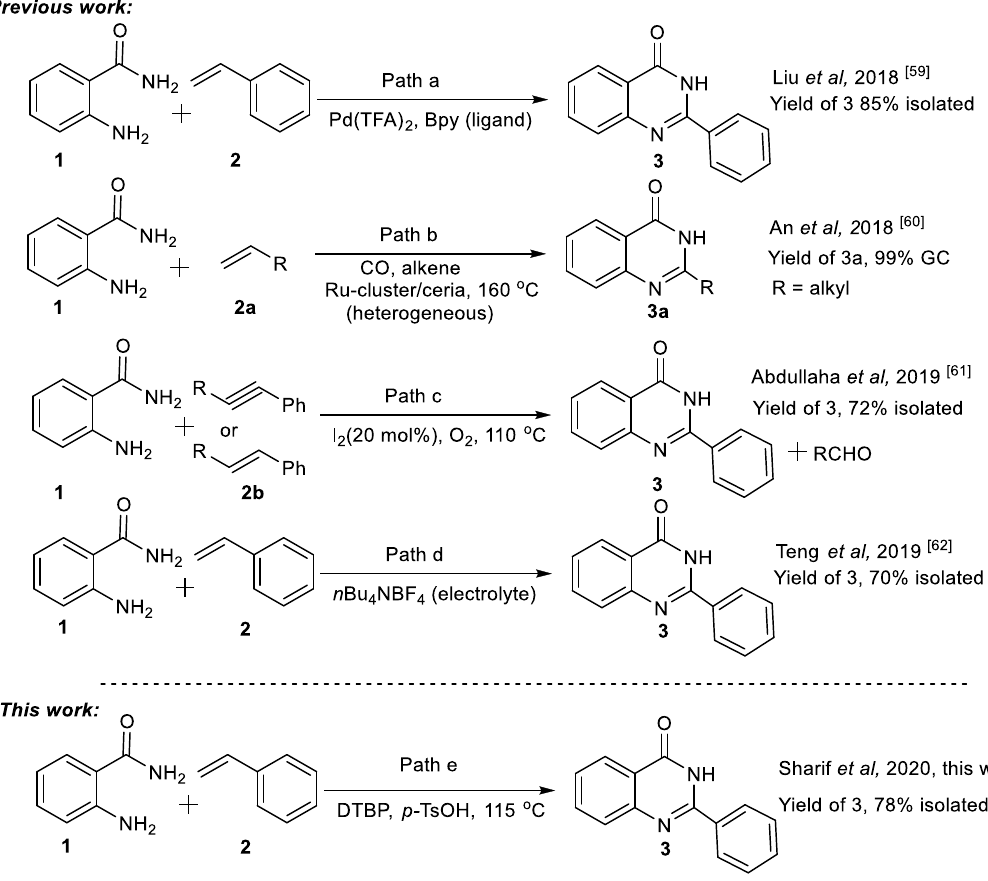
ff erent routes for the synthesis of Quinazolin-4(3 H Figure 2. Different routes for the synthesis of Quinazolin-4(3 H )-ones. Figure 2. Di